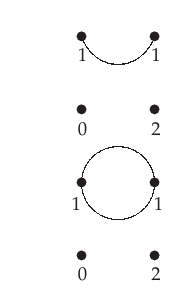
Figure 13: Tangles for E i and E i E − i E i , (cid:2) λ i ,λ i (cid:9) 1 (cid:3) (cid:8) (cid:2) 0 , 2 (cid:3)